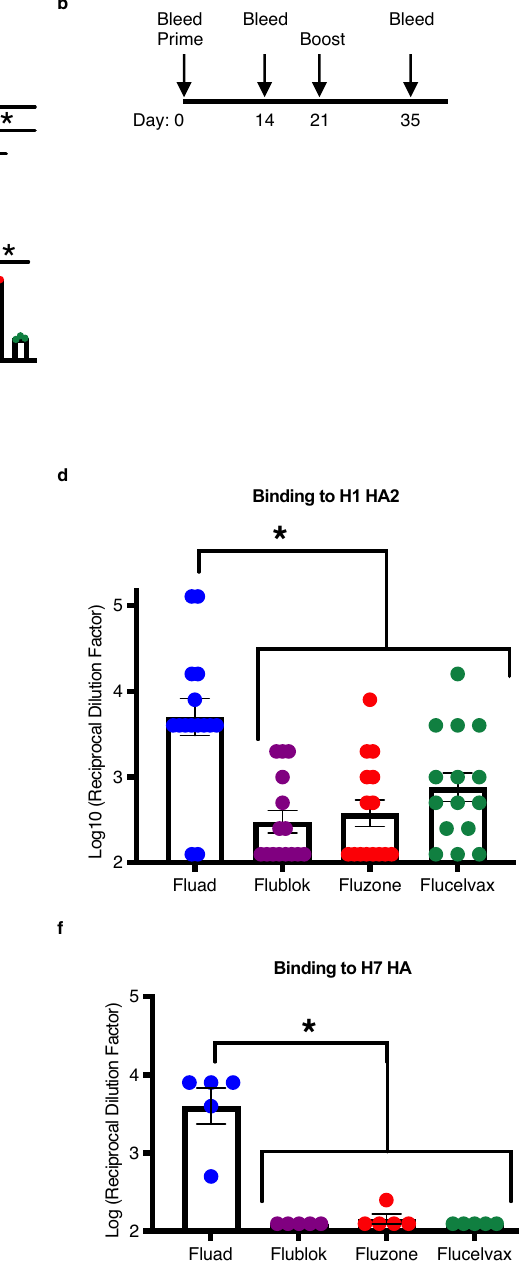
Fig. 5 | Commercial vaccine stem-epitope availability and cross-reactive immunogenicity. a ELISA binding analysis of commercial vaccines (Fluad (blue), Flublok (purple), Fluzone HD (red), Flucelvax (green)) by HA stem monoclonal antibodies (FI6v3, CR6261, C179). Vaccine samples were normalized for H1 HA amountpriortoplating.RecombinantH1HAprotein(H1HAA/Michigan/45/21015,